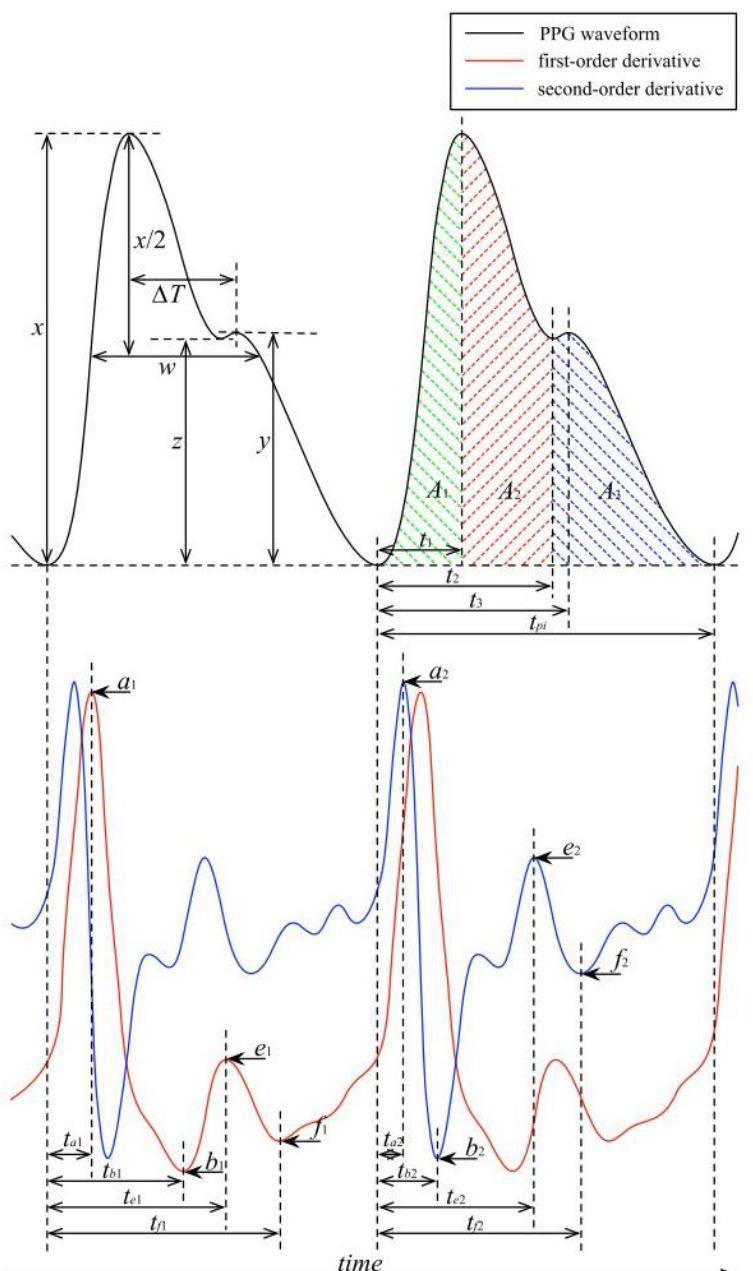
Figure A1. Considered feature points on the PPG pulse waveform and its corresponding first-order and second-order derivatives. All credit goes to the original author of the image [27].